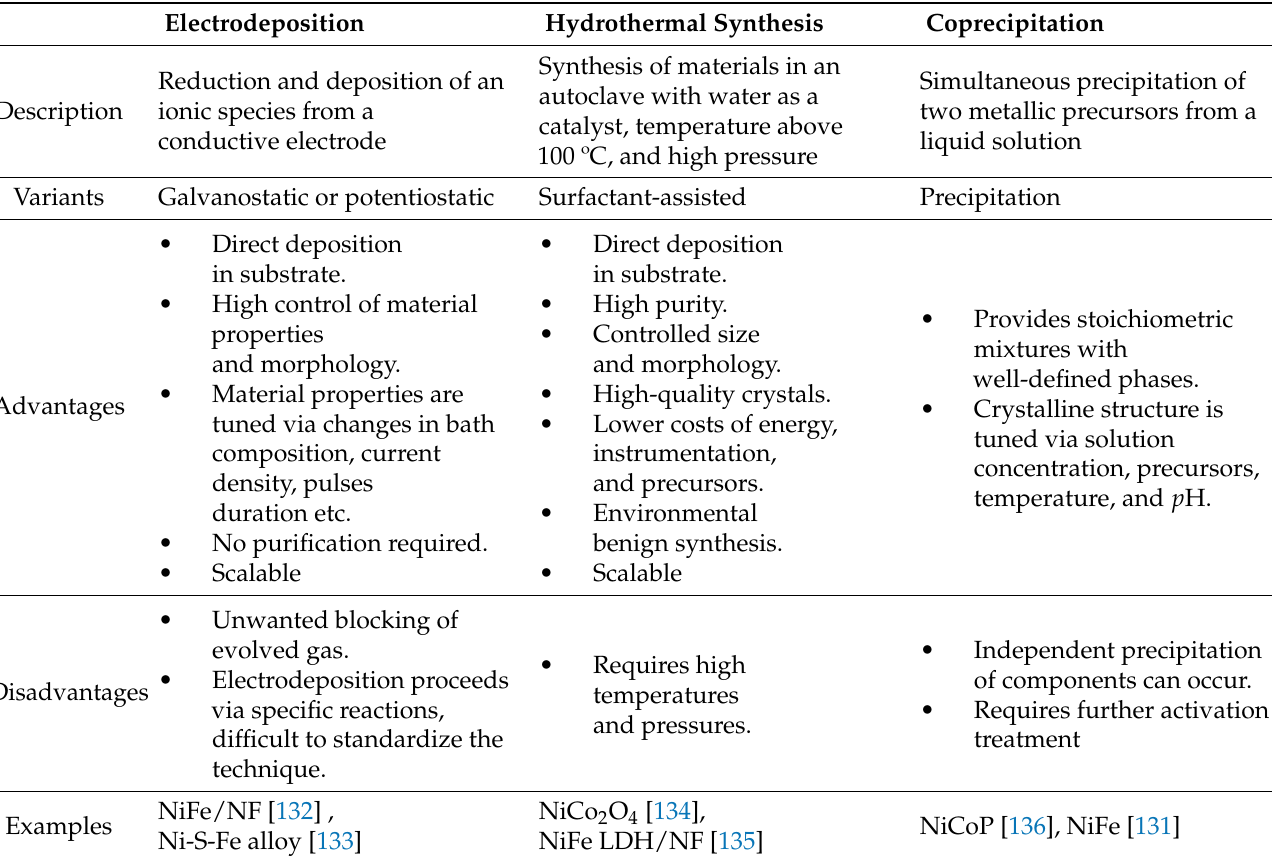
Table 2. Common synthesis techniques for nickel-based